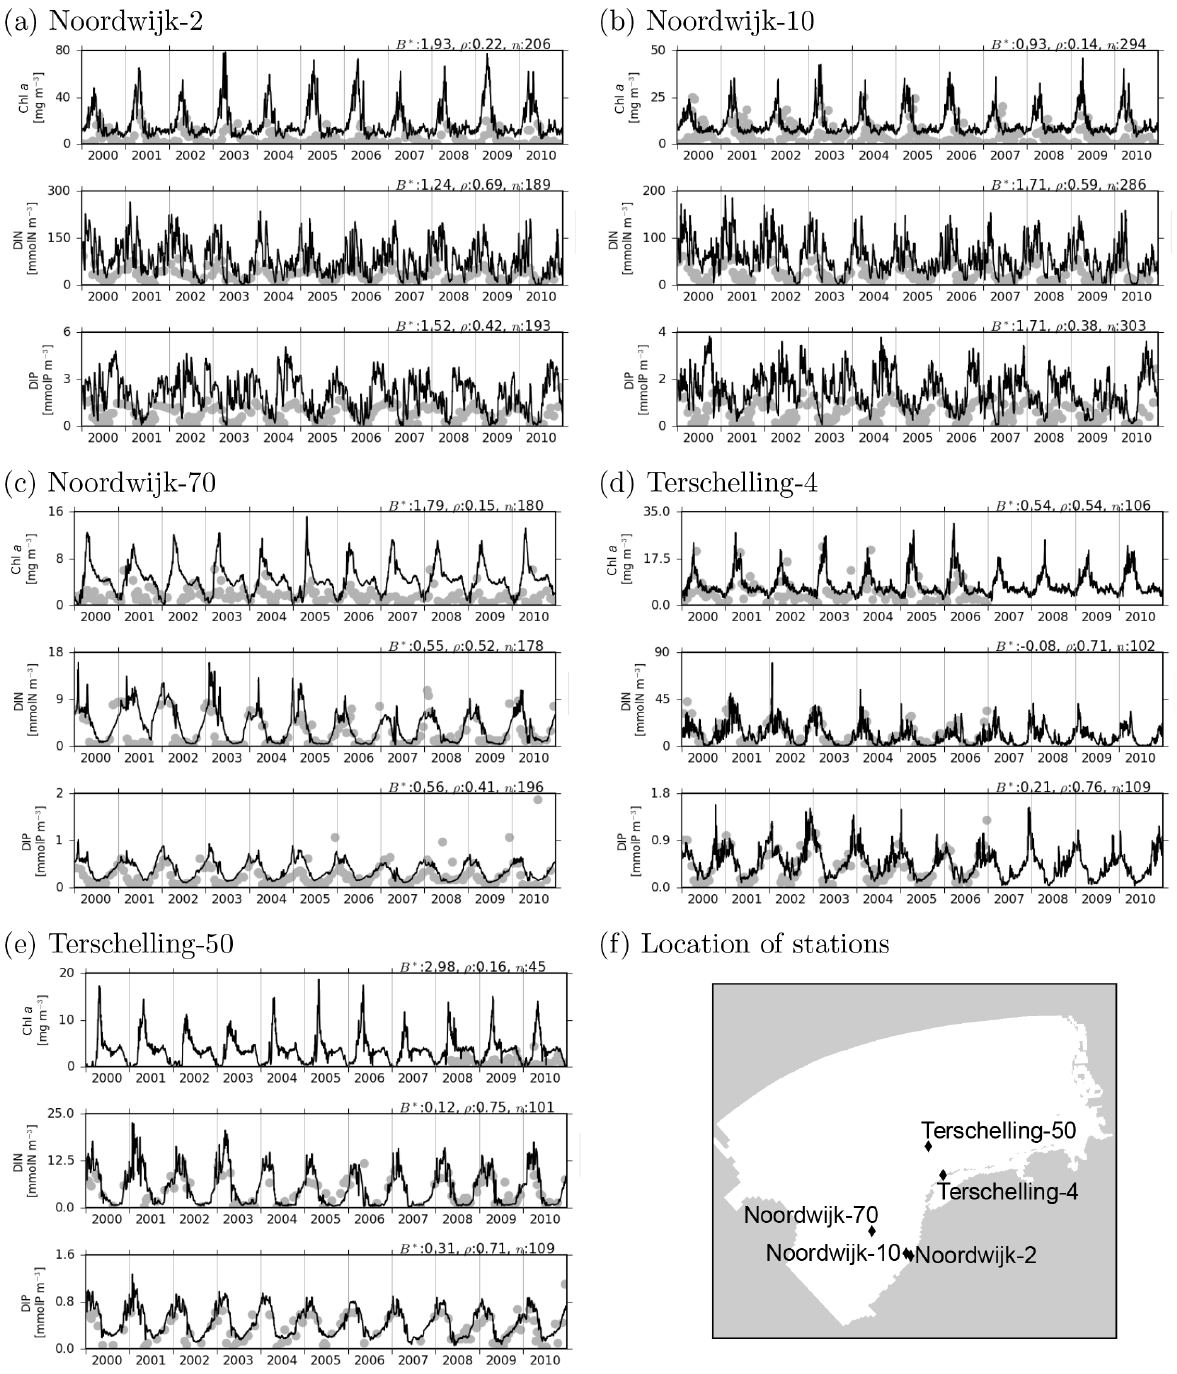
Figure 6. As in Fig. 5, but for the stations located along the coasts of the Netherlands, operated by